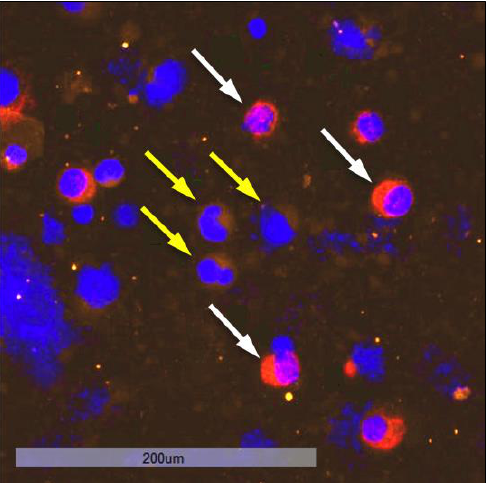
Figure 4. Staining of ZR75-1 cells (white arrows), which stain positive for ER (red) while remaining negative for N-cadherin, next to T98G cells (yellow arrows), which stain positive for N-cadherin (yellow) and negative for ER at 20-fold magnification.